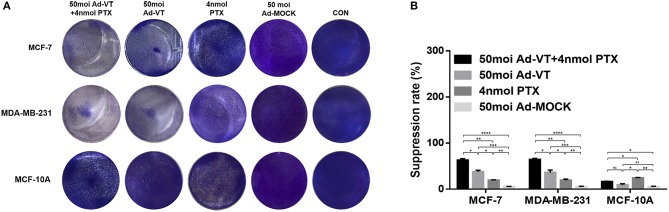
Inhibitory effect of the combination Ad-VT and paclitaxel on MCF-7, MDA-MB-231, and MCF-10A cells. (A) MCF-7, MDA-MB-231, and MCF-10A cells were infected with Ad-VT, Ad-MOCK, paclitaxel, and Ad-VT and paclitaxel mixture, then stained with 0.4% Crystal Violet at 72 h. Ad-VT, paclitaxel and the combination of Ad-VT and paclitaxel exerted inhibitory effects on MCF-7 and MDA-MB-231 cells. Ad-VT is substantially non-toxic to MCF-10A cells. Paclitaxel showed a cytotoxic effect in MCF-10A cells, and this was reduced when Ad-VT and paclitaxel were combined. (B) MCF-7, MDA-MB-231, and MCF-10A cells viability were determined using WST-1 assays after infection with Ad-VT, paclitaxel and Ad-VT and paclitaxel mixture for 72 h. The inhibitory effect of combination Ad-VT and paclitaxel group had a significantly difference with other groups on breast cancer cells. All measurements were performed in triplicate. *p < 0.05, **p < 0.01, ***p < 0.001, ****p < 0.001.